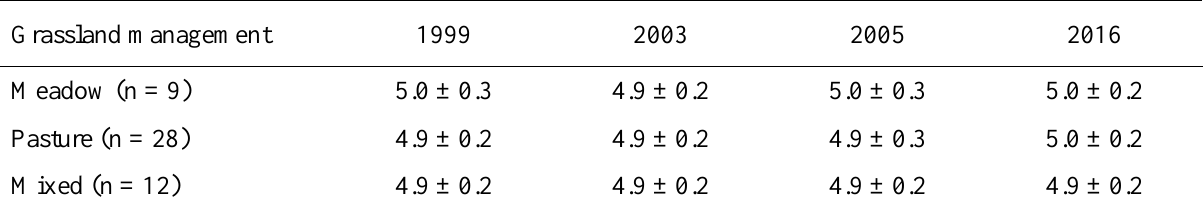
Table 5. The pH values of the topsoil (0–10 cm) by survey year and type of grassland management (mean ± standard